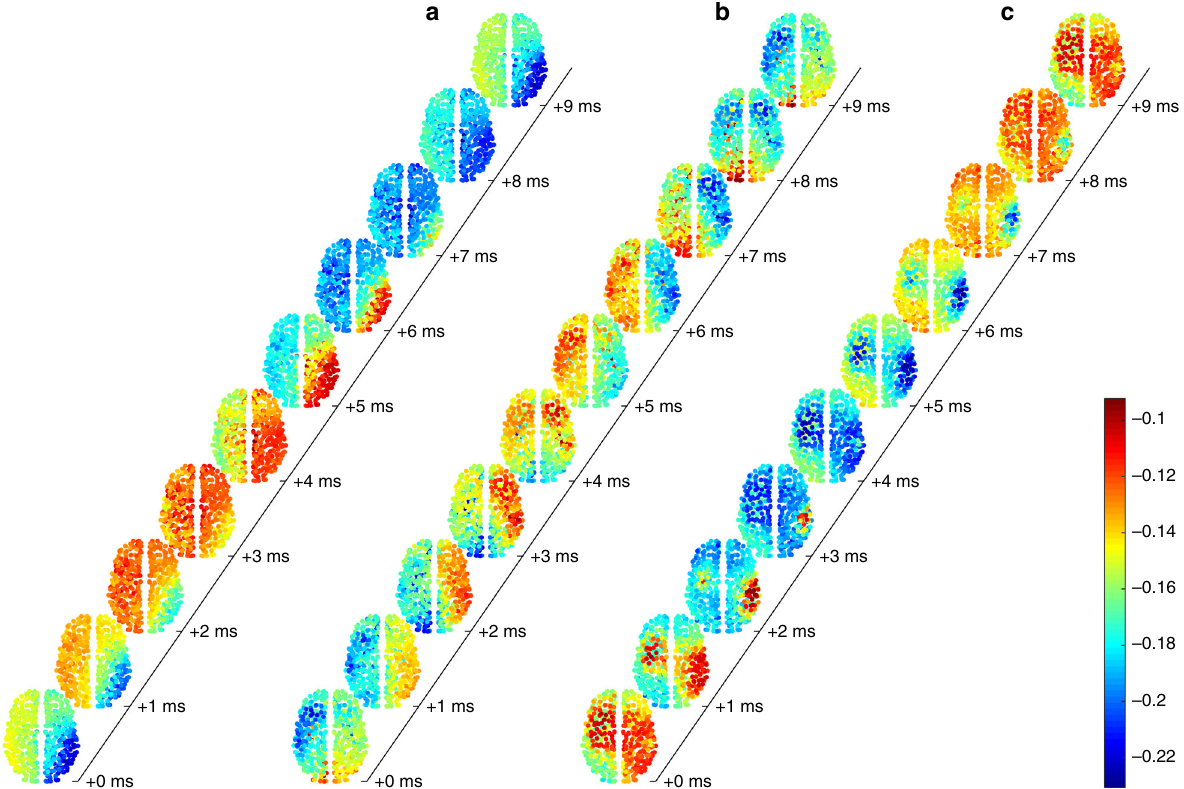
Fig. 1 Large-scale wave patterns in the model. Ten snapshots of the dynamics of the pyramidal mean membrane potential V at latencies indicated on the time axes, for a a traveling wave, b a rotating wave, and c a pattern with sinks (red areas shrinking for latencies 0 – 3 ms) and diffuse sources (broad red areas emerging for latencies 6 – 9 ms). These results are for strong coupling c = 0.6 and short delay τ = 1 ms